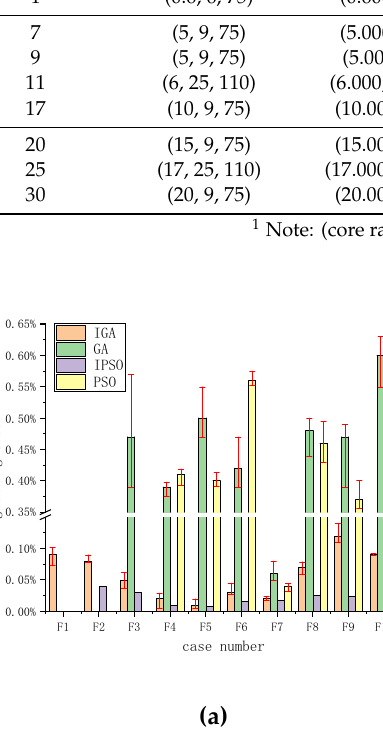
Table 3. The machined flute parameters.